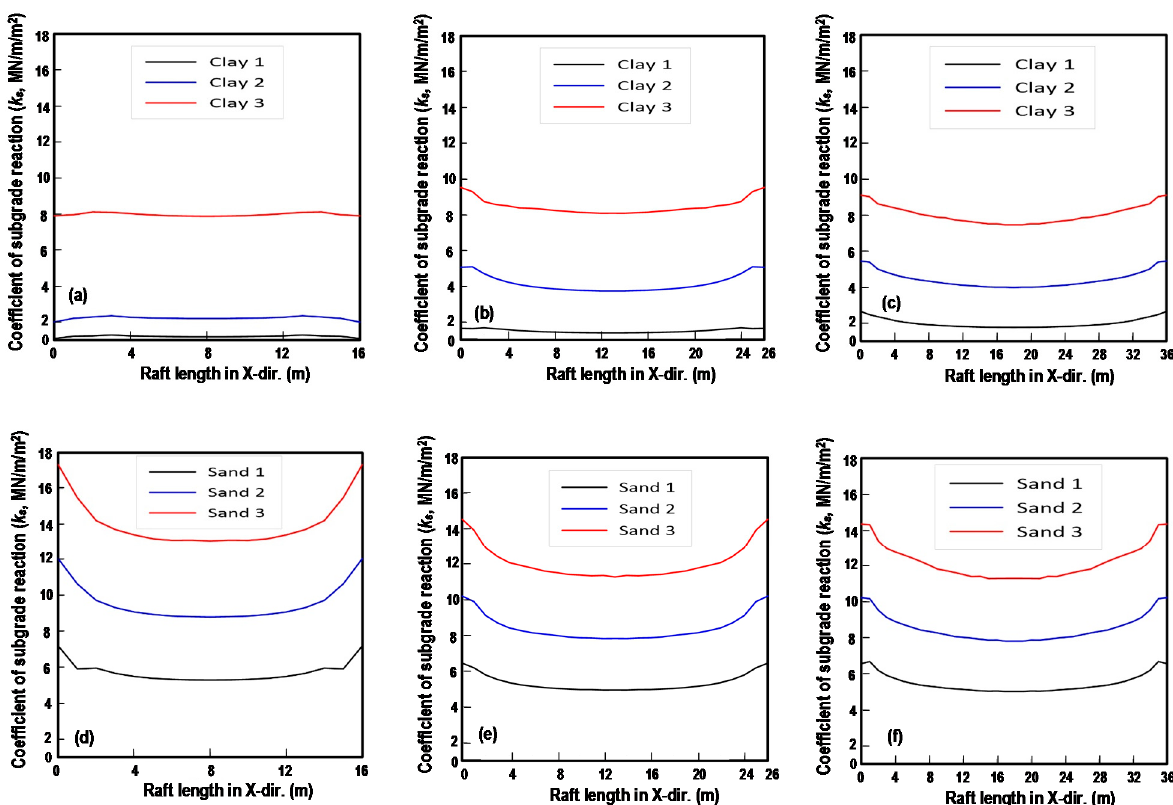
Figure 7. Coefficient of subgrade reactions for square raft foundations with different dimensions: